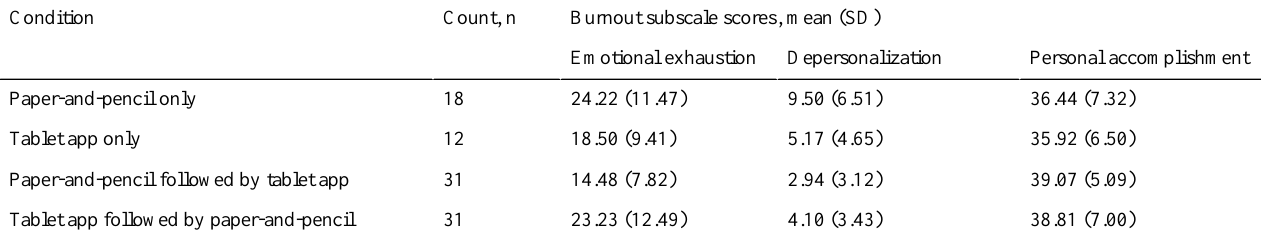
Table 4. Burnout subscale scores for each condition.